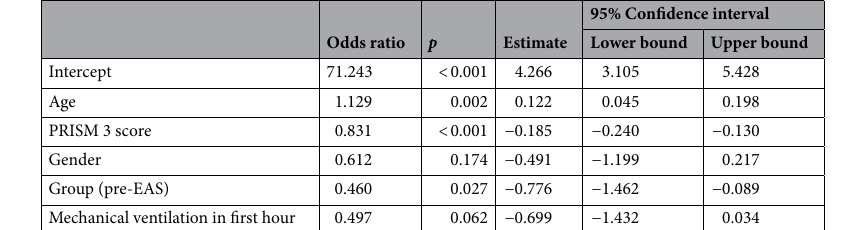
Odds ratio p Estimate